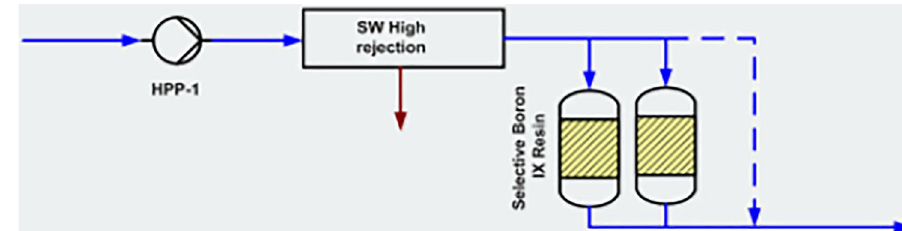
Fig. 8 Integration of single stage RO and IX for boron removal (Lenntech